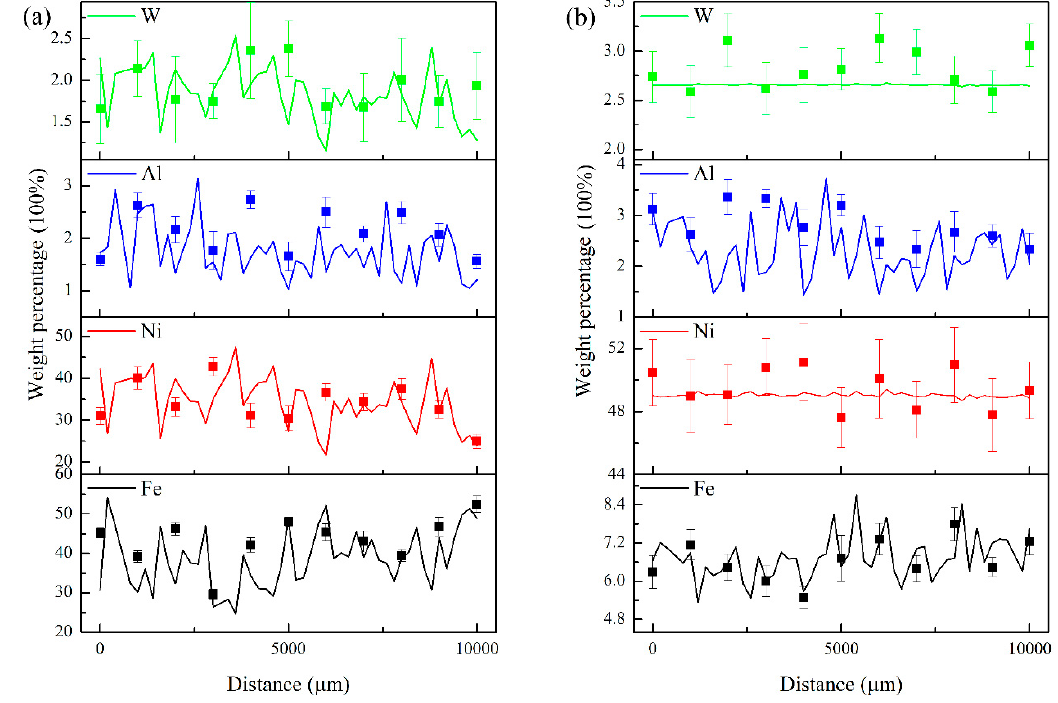
Figure 11. Monitoring results of weight percentage of Fe, Ni, Al and W, the points show the composition tested by EDS, and the lines show the composition predicted by the emission spectroscopy. ( a ) 800 W, 5 mm / s and 0.3 mm of thickness; ( b ) 2000 W, 20 mm / s and 0.8 mm of thickness.